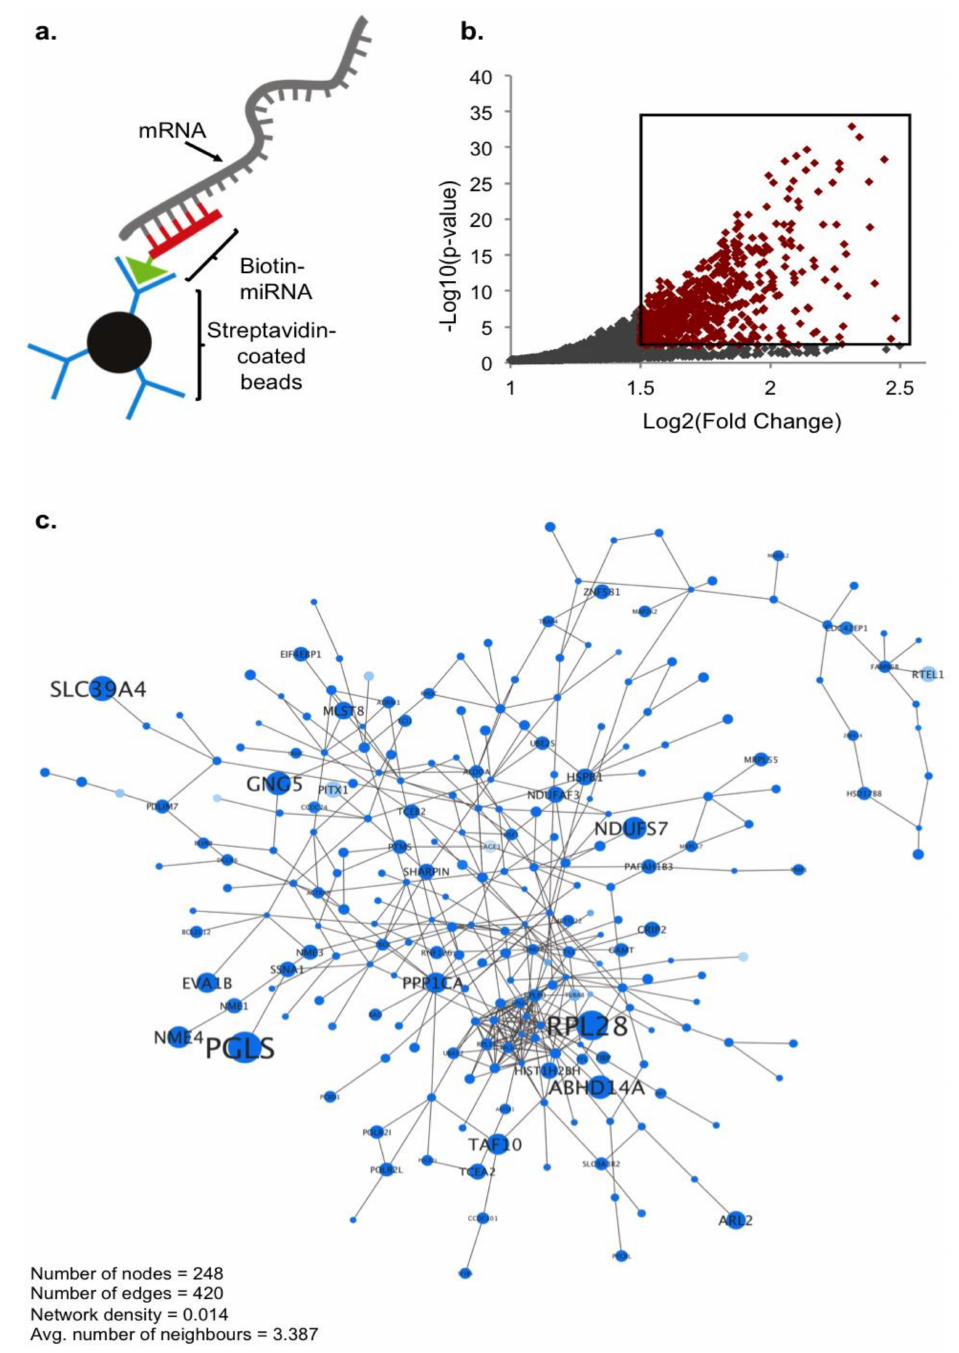
Figure 1. RNA sequencing (RNAseq) identification of genes enriched by miR-210 pull-down. ( a ) Schematic of the biotin–streptavidin pull-down approach used to isolate miR-210 target RNA. ( b ) Scatter plot of pull-down RNAseq data: 676 genes, highlighted in red, were found to be significantly enriched by hsa-miR-210 compared to cel-miR-239b using the following thresholds: Log2 (fold change) > 1.5, adjusted p -value < 0.05, n = 3 biological replicates, DEseq2: Wald “greater” test of significance, log fold change (lfc) threshold = 1. ( c ) Interactome network of genes significantly enriched by miR-210. Increasing node and font size correlate to increasing fold change; decreasing node saturation correlates to increasing p